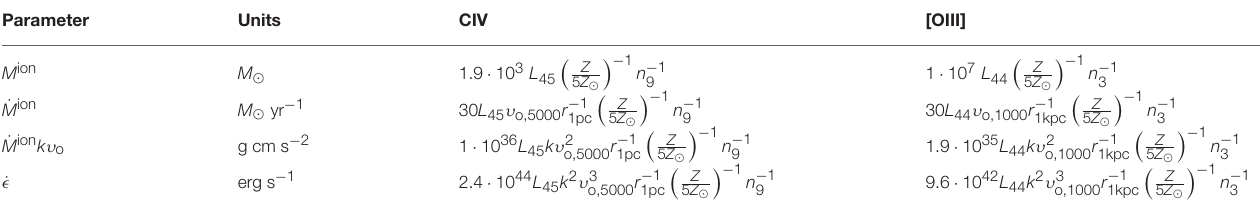
TABLE 1 | Outflow physical parameters derived for CIV and [OIII]: mass of ionized gas, mass outflow rate, thrust and kinetic power. Parameter Units